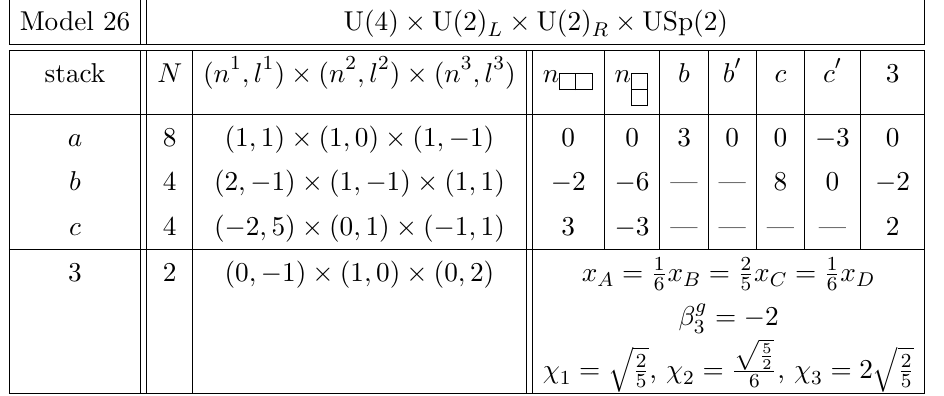
Table 33 . D6-brane configurations and intersection numbers of Model 26, and its MSSM